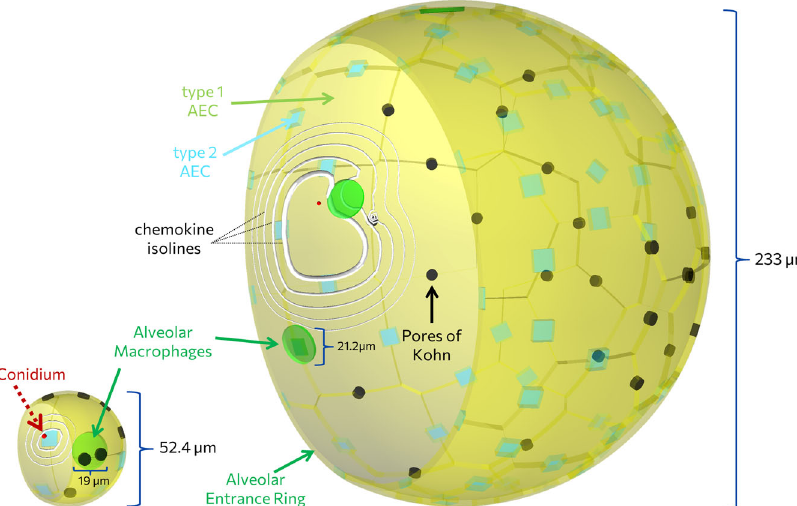
Fig. 1 To-scale representation of the murine (left) and human (right) alveolus. The alveolus is modeled as a 3/4 sphere composed of an epithelial cell layer consisting of alveolar epithelial cells (AEC) type I (yellow) and type II (blue). A single Aspergillus fumigatus conidium (red) is randomly positioned on the inner alveolar surface and the contacting AEC is secreting chemokines (white isolines) to attract AM (green) towards the conidium. The alveolar entrance ring and the pores of Kohn (black) are the boundaries of the system.